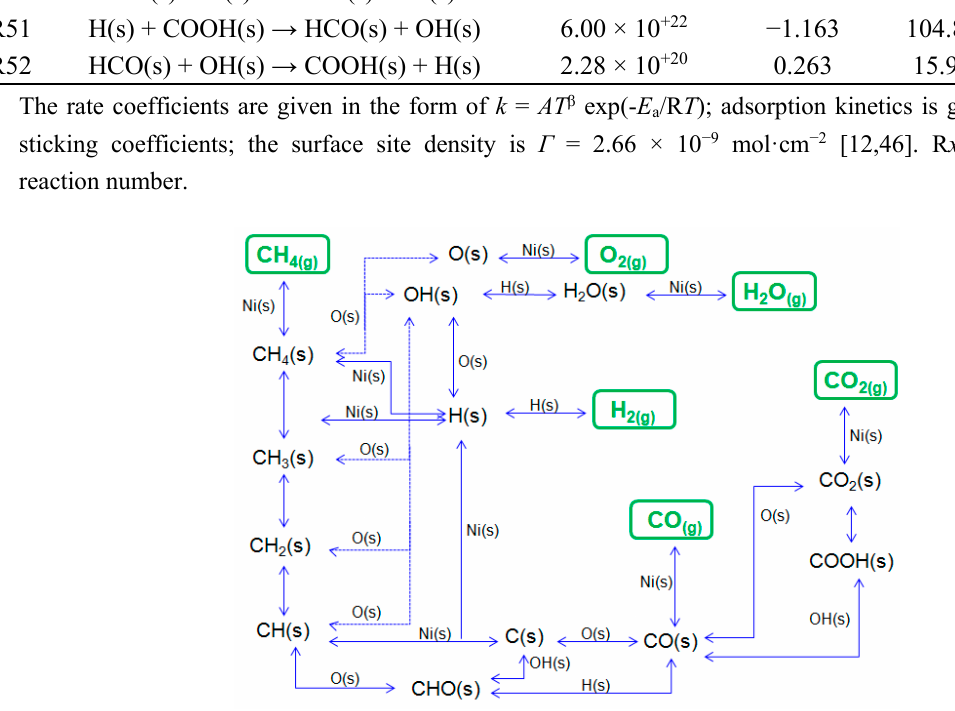
Figure 2. Reaction pathways for methane oxidation and